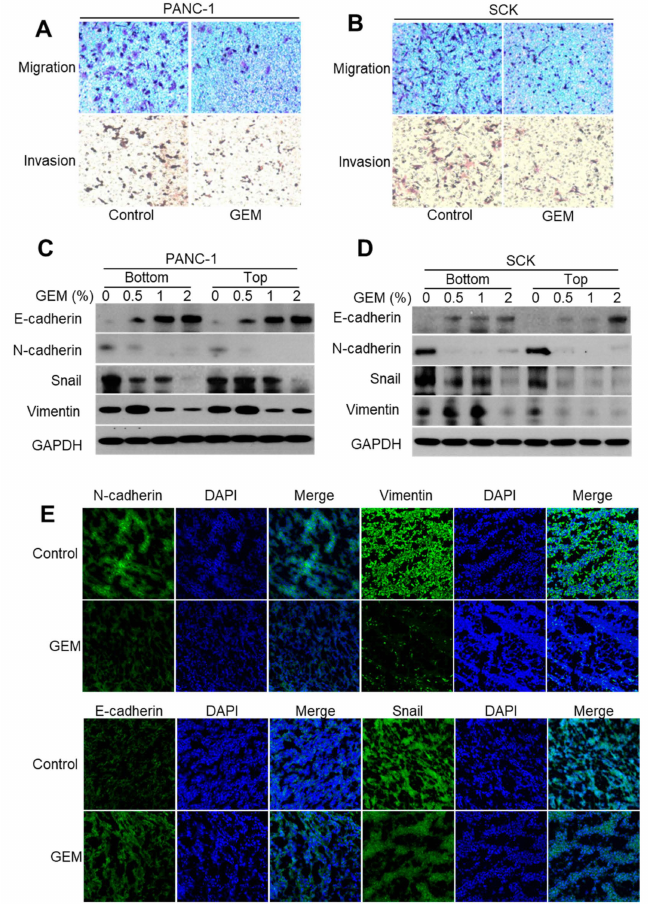
Figure 5. Gemcitabine-eluting membrane (GEM) implantation suppresses the epithelial–mesenchymal transition (EMT) in xenograft tumors. ( A , B ) Transwell migration and invasion assays of SCK and PANC-1 cells. ( C , D ) Western blot analysis of E-cadherin, N-cadherin, snail, and vimentin expression at the bottom and top of SCK and PANC-1 tumor tissues after implantation with the GEM containing the indicated concentrations of gemcitabine. ( E ) Results of representative immunofluorescence analyses of E-cadherin, N-cadherin, snail, and vimentin in tissues from SCK tumors implanted with the GEM or control